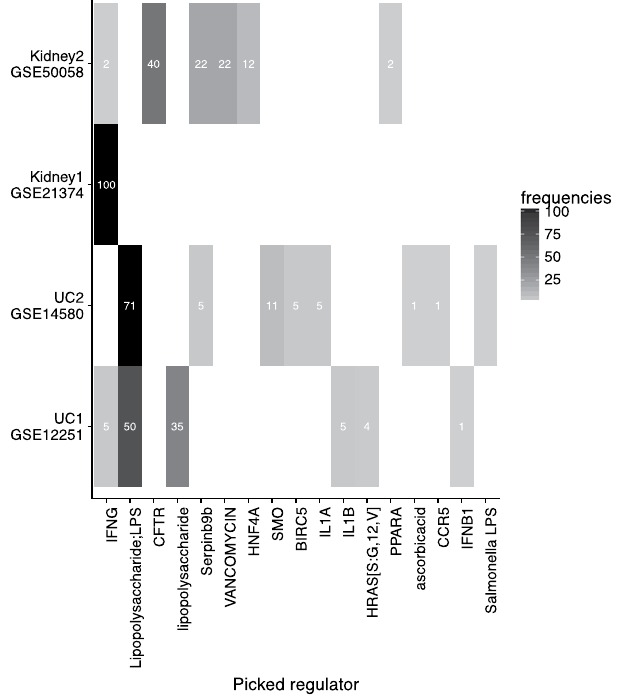
Figure 5. The heatmap shows heterogeneity in picked regulators within and between datasets based on 100 bootstrap runs. Any regulator that was picked at least once in any dataset is displayed. Numbers indicate the number of times a specific regulator was chosen in the 100 bootstrap runs conducted for each